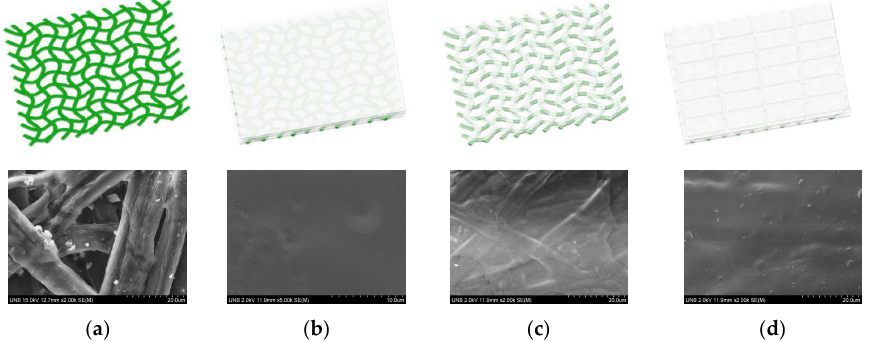
Figure 5. Schematic and surface morphology of original and coated paper. Original paper (Scale: 20 μm, ( a )). PVA gel coated paper (23 °C, 50% RH, scale: 10 μm, ( b )). PVA gel coated paper (38 °C, 90% RH, scale: 20 μm, ( c )). PVA/NC gel coated paper (38 °C, 90% RH, scale: 20 μm, ( d )).